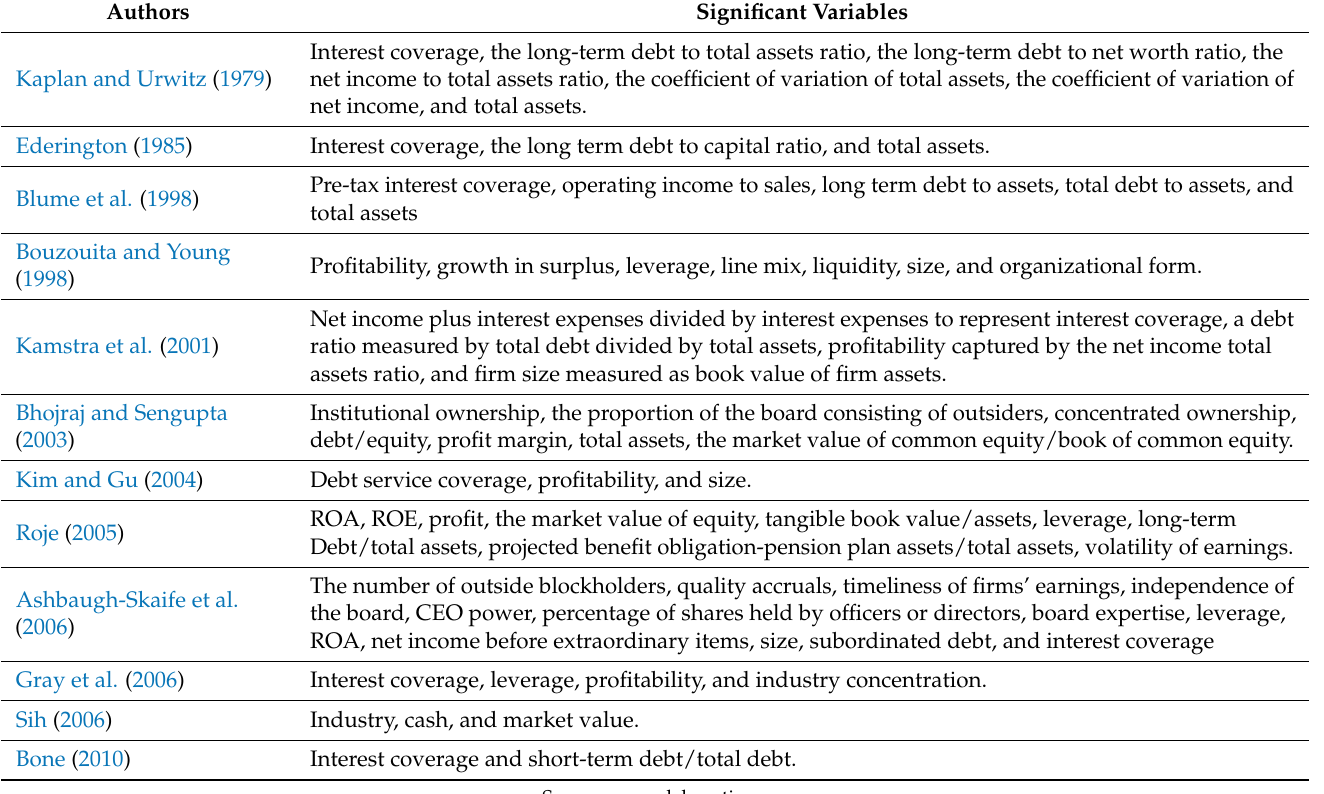
Table 2. Studies about financial factors influencing on corporate credit